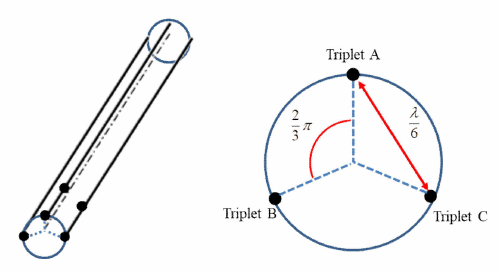
Figure 3. Structure of the triplet towed array where λ is the wavelength of design frequency.